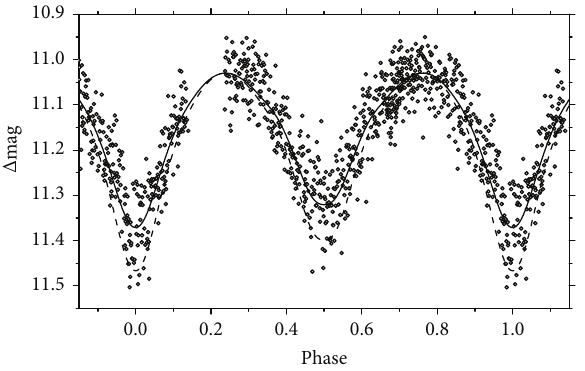
Figure 2: The observed (open circles) and theoretical (solid line) light curve of V921 Her. Theoretical light curve without being contaminated by the third light is plotted with dashed line (Mode 3).